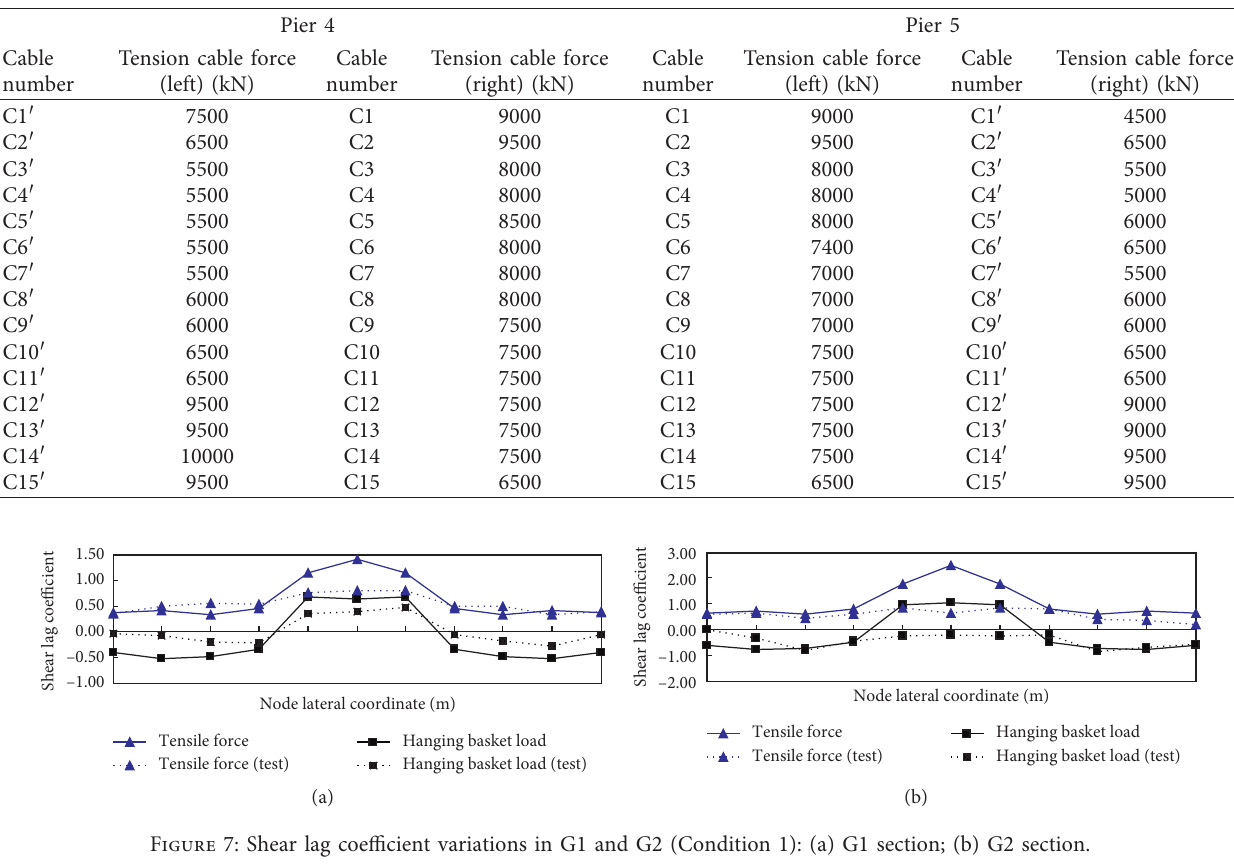
Table 1: Initial cable tension of each stay cable.